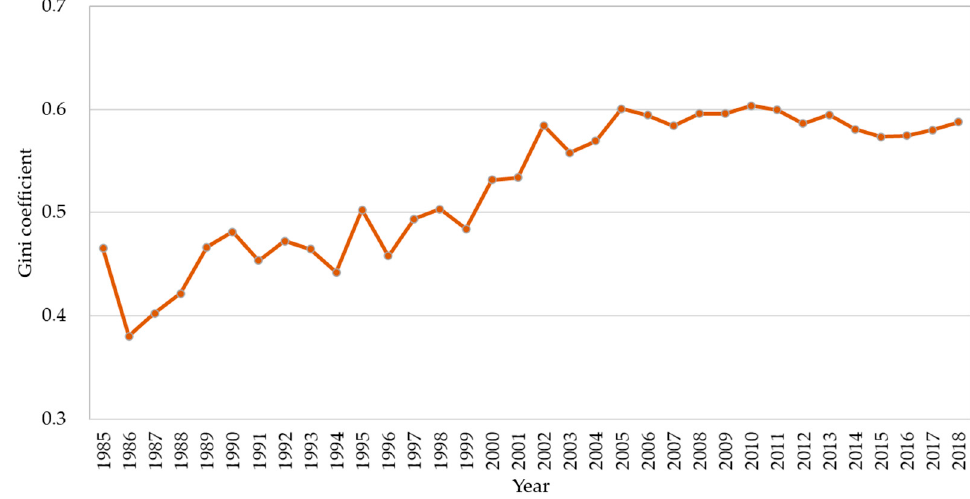
Figure 3. Gini coefficient of green invention patent applications for the period 1985–2018.